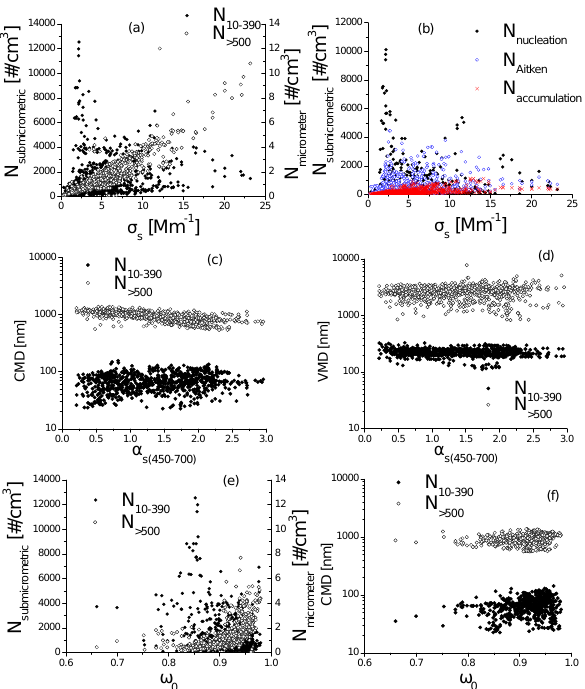
Fig. 8. Classification of air masses according to their origin. Per- centage values refer the frequency of each air mass origin. (a, b) Summarizes the main characteristics of the optical properties of the aerosols for the six air-mass types. The mean values of σ a , σ s and ω 0 for 550nm and α a , α s and α ω for the pair of wavelengths 450– 0 700nm are shown for each sector. (c) Number concentrations ob- served in each